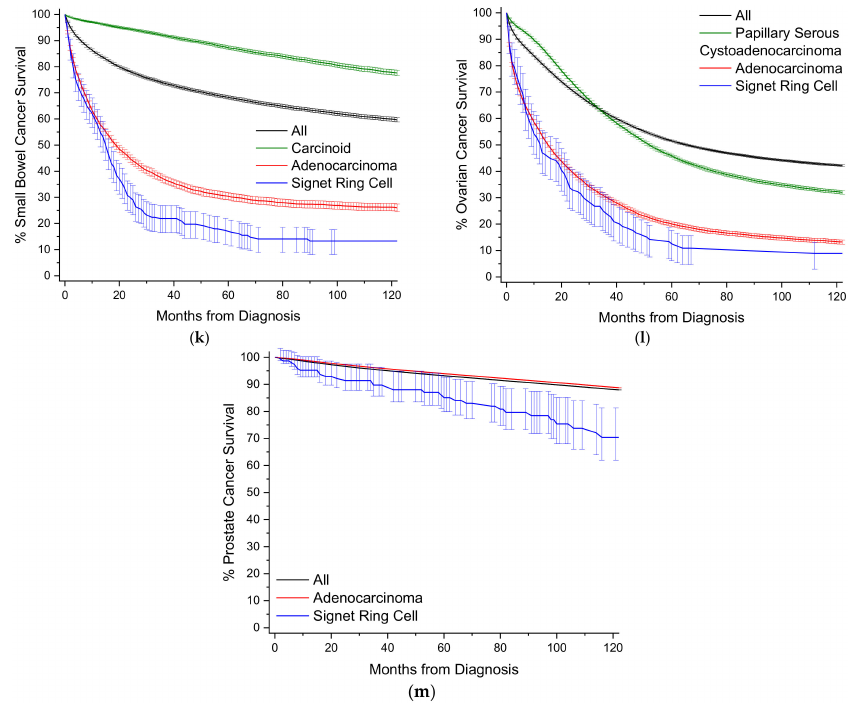
Figure 3. Kaplan-Meier survival curves. All survivor functions are shown with 95% confidence intervals. ( a ) Gastric cancer. ( b ) Colon cancer. ( c ) Esophageal cancer. ( d ) Rectal cancer. ( e ) Lung cancer. ( f ) Pancreatic cancer. ( g ) Appendiceal cancer. ( h ) Gallbladder / Biliary cancer. ( i ) Breast cancer. ( j ) Urinary Bladder cancer. ( k ) Small Bowel cancer. ( l ) Ovarian cancer. ( m ) Prostate cancer. In these curves, “All” represents the curves for all cancers within that site, with subtypes shown as labelled.